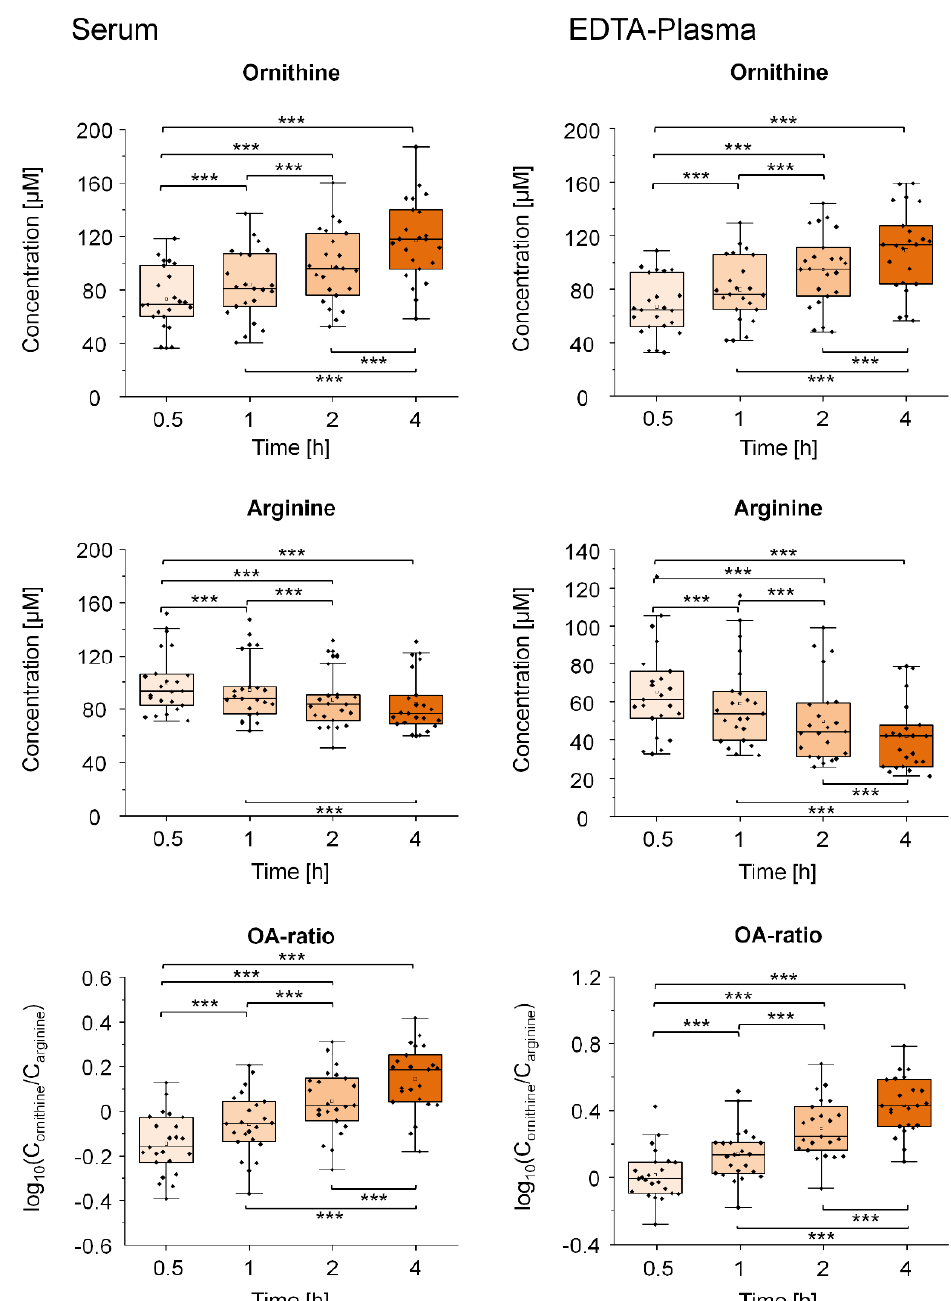
Figure 5. Impact of precentrifugation delay on arginine and ornithine in human serum and EDTA plasma. Boxplots display the variation of the concentration of arginine and ornithine in serum and EDTA plasma ( validation sample 2 , n = 23) of healthy volunteers after a prolonged incubation for 0, 0.5, 1, 2 and 4 h at room temperature before centrifugation. Additionally, diagnostic thresholds were calculated based on the identified pathway connections and the measured concentrations for both amino acids. Asterisks indicate differences between the time points as indicated by the respective brackets (*** p < 0.001). P -Values were calculated using linear mixed models or paired t -tests and corrected for multiple testing using Bonferroni post-hoc test.